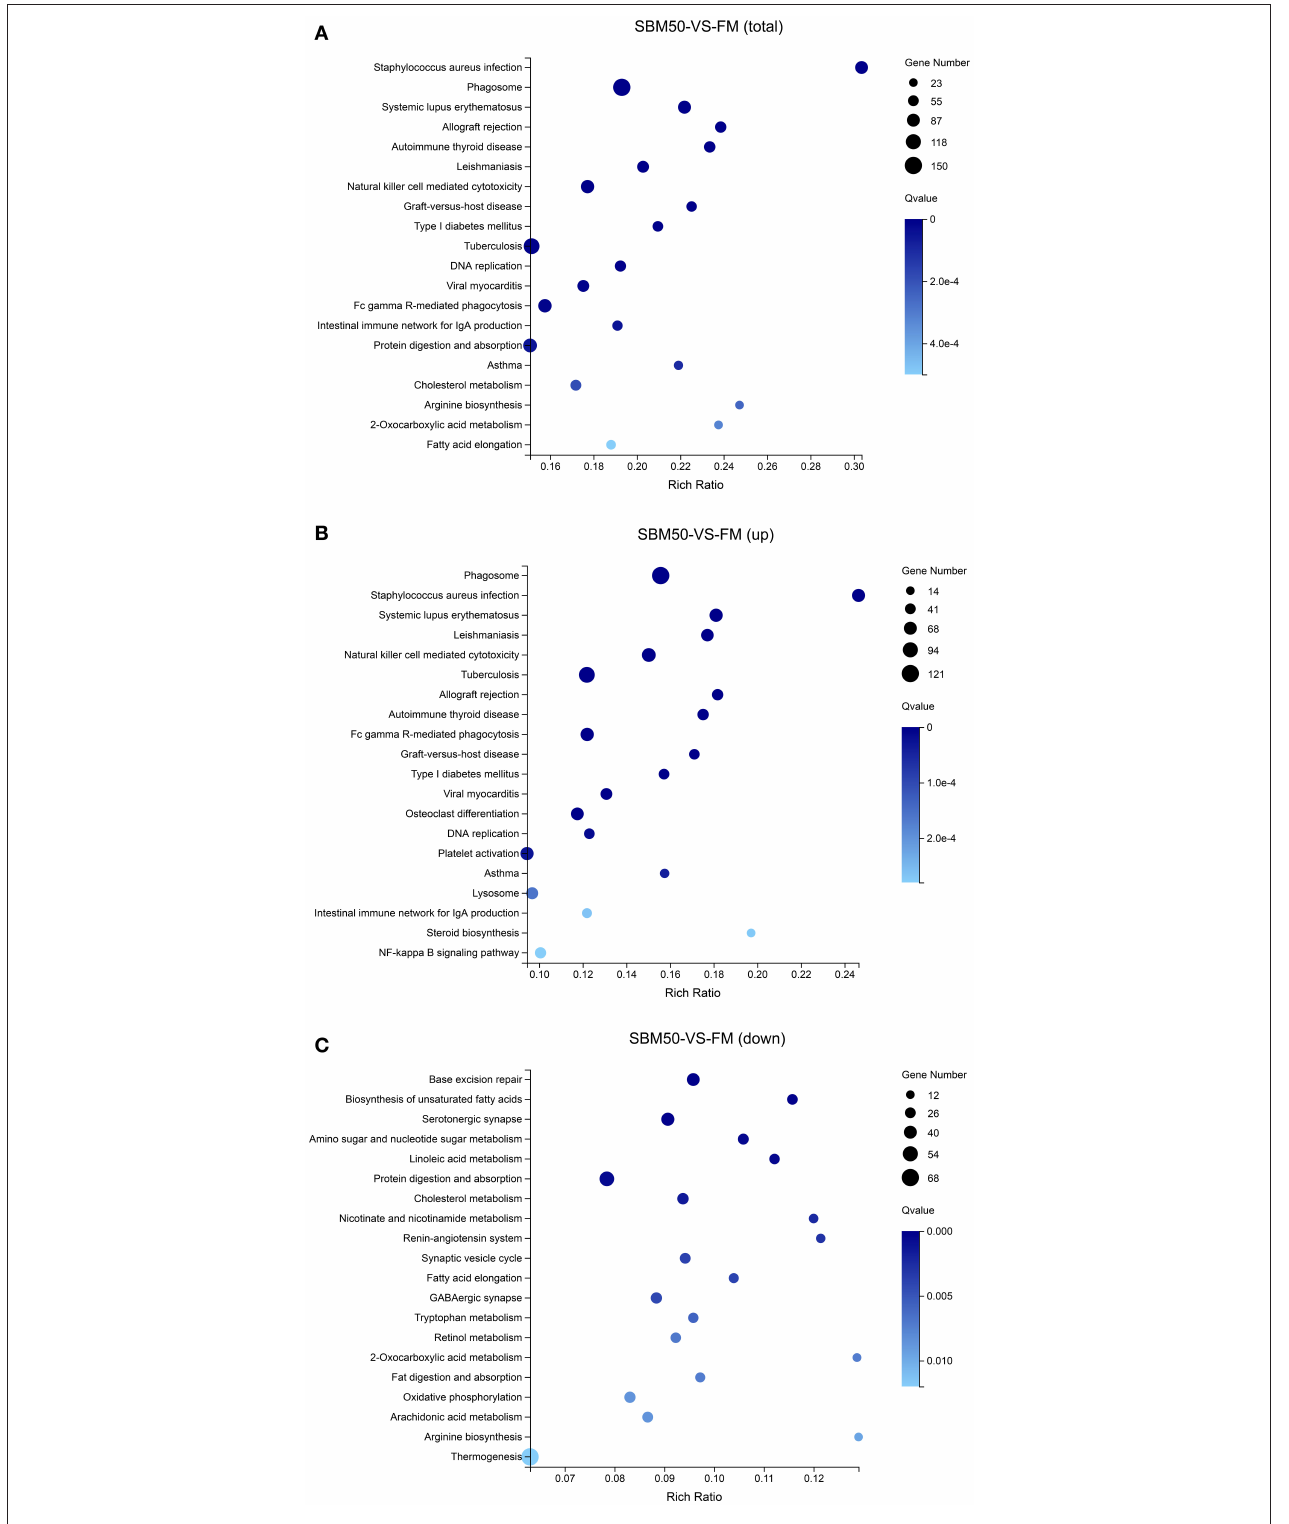
FIGURE 3 | Enrichment analysis of the top 20 KEGG pathways for differentially expressed genes (DEGs). The horizontal axis represents the rich ratio, and the vertical axis represents the name of the KEGG pathway. The size of the bubble represents the number of genes annotated to the pathway. The color expresses the enriched Q -value. (A) KEGG pathways enriched by the total DEGs. (B) KEGG pathways enriched by the upregulated DEGs. (C) KEGG pathways enriched by the downregulated DEGs.